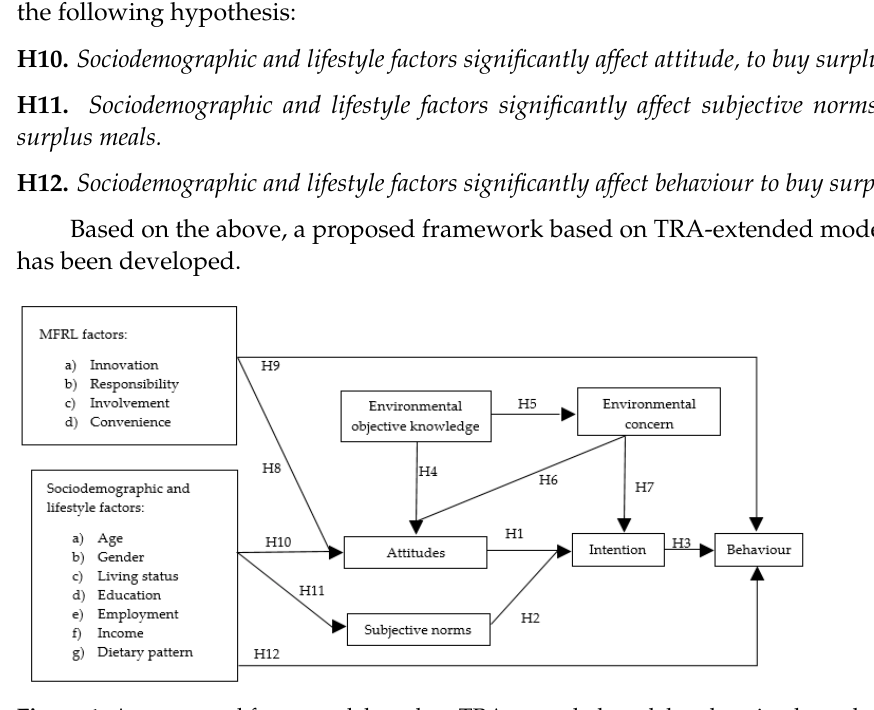
Figure 1. A conceptual framework based on TRA-extended model and testing